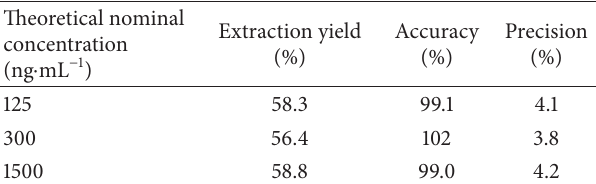
Table 1: Extraction recovery, precision, and accuracy of the method ( 𝑛 = 7 ).